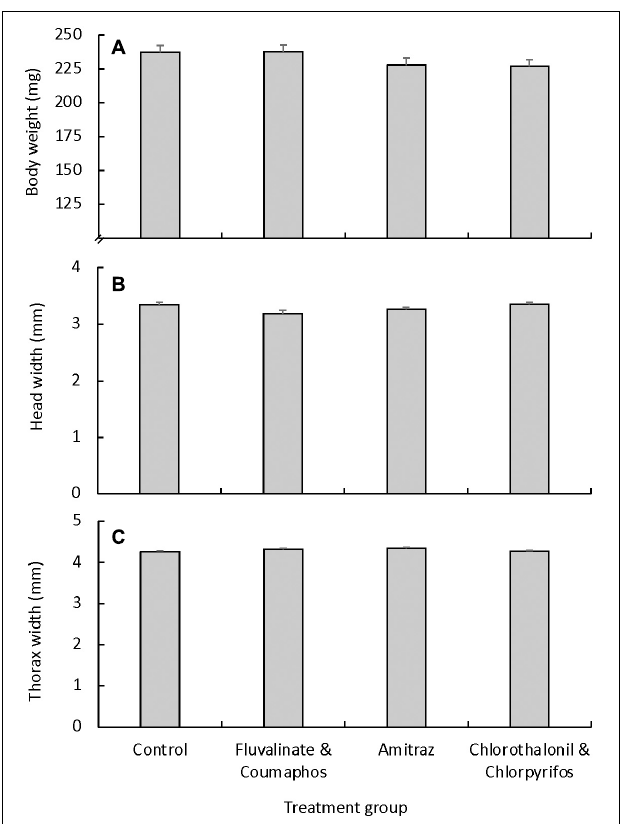
FIGURE 2 | External morphology measurements (mean ± S.E.M.) for mated queens that were reared under different pesticide exposure conditions. Queens were grafted into plastic cups that were coated with pesticide-free molten wax (control group; n = 18), or wax containing either a combination of tau -fluvalinate and coumaphos ( n = 10), amitraz alone ( n = 11), or a combination of chlorothalonil and chlorpyrifos ( n = 10). We found no differences across treatment groups for either (A) body weight [ F ( 3 , 48 ) = 0.99, p = 0.49], (B) head width [ F ( 3 , 48 ) = 1.28, p = 0.27] or (C) thorax width [ F ( 3 , 48 ) = 1.23, p = 0.30].